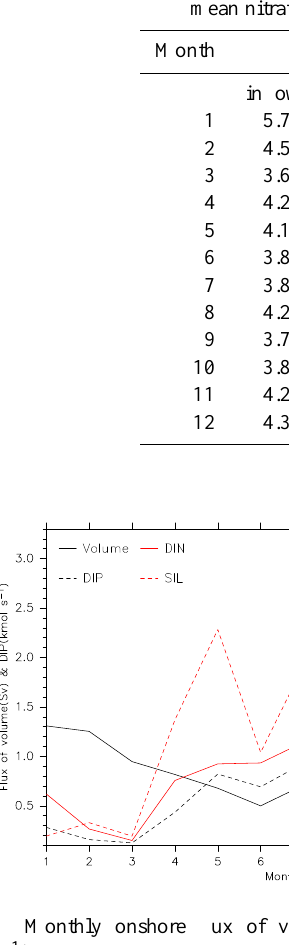
Monthly onshore flux of volume (Sv) and nutrients (kmols − 1 ) across the entire 200-m isobath shown in Fig. 1. The positive flux direction is toward the ECS shelf. The black solid line denotes volume, the red solid line DIN, the black dashed line DIP, and the red dashed line